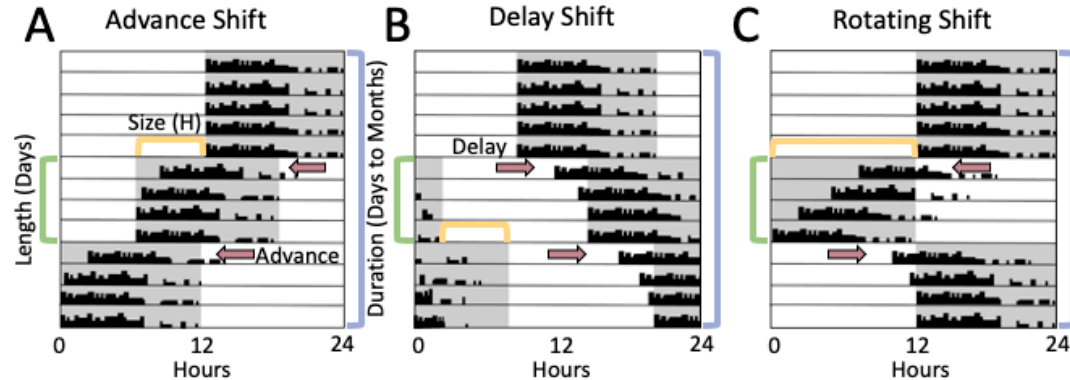
Figure 3. Commonly used light shift paradigms in rodent study models. Single plotted actogram examples of rodent locomotor activity to describe methods commonly utilized to evaluate the influence of light shifts. Shaded areas indicate time of lights OFF, and white areas indicate time of lights ON over a 24 h day. Three main types of light-shift paradigms separated by shift direction, with advancing shifts ( A ), delaying shifts ( B ), and ( C ) rotating combination of advancing and delaying shifts. Other variables important to light-shift paradigms include shift size (time in hours (H) of the shift, typically ranging between 3 and 12 h), shift length (number of days between shifts, indicated by the green brackets), and shift duration (number of days exposed to the shift paradigm, indicated by blue brackets). Arrows indicate day and direction of shift. Table 2. Summary of outcomes in rodent light-shift models included in this review.